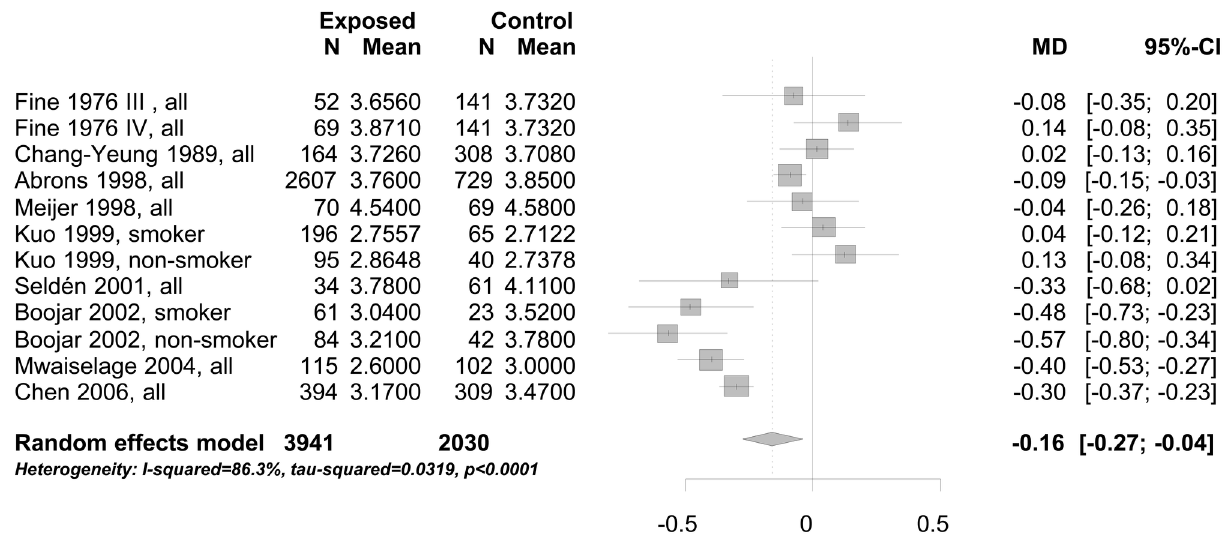
Figure 2. Mean difference (MD) of FEV1 [liter] between study participants exposed to bg dust at the workplace and no/low exposed participants.